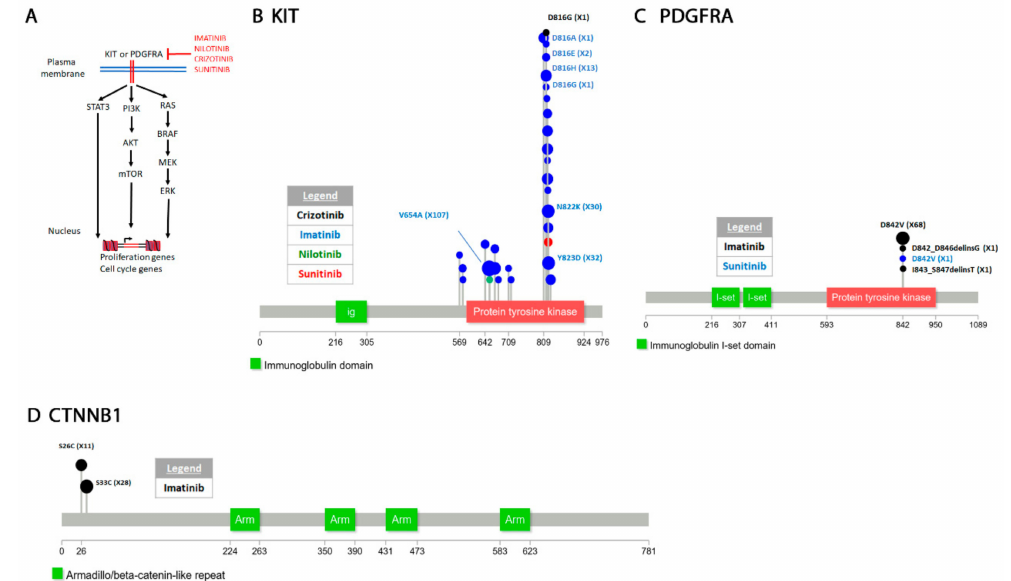
Figure 3. Signaling and mutations arising in gastrointestinal stromal tumors (GIST) soft tissue. ( A ) The KIT or PDGFRA receptor tyrosine kinases signal to at least three pathways to activate transcription of proliferation and cell cycle genes. The two receptor tyrosine kinases (RTKs) acquire resistance in response to the drugs shown. ( B–D ) Diagrams of resistant mutations in some of the genes targeted by the drugs shown in ( A